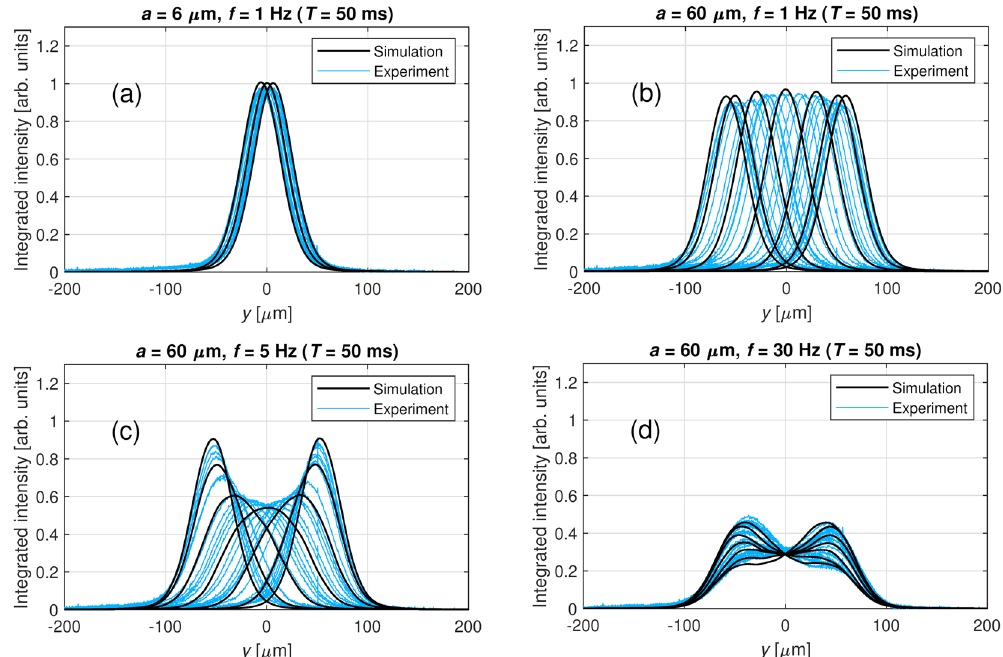
FIG. 9. Integrated intensity (vertical profiles) from the experiment (blue lines) and simulation (black lines). The beam was excited with amplitudes and frequencies of (a) 6 μ m, 1 Hz, (b) 60 μ m, 1 Hz, (c) 60 μ m, 5 Hz, and (d) 60 μ m, 30